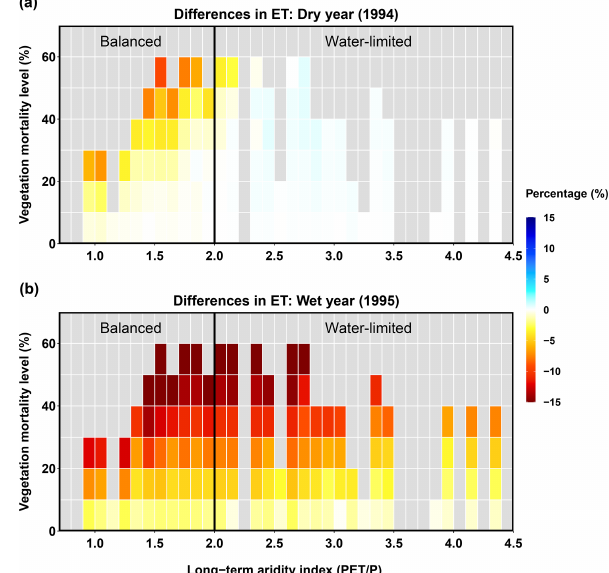
Figure 7. Relationships between long-term aridity, vegetation mor- tality level, and differences in evaporation for a dry year (1994, a ) and a wet year (1995, b ). Differences are calculated as the normal- ized differences (%) in evaporation between each evergreen mortal- ity scenario and the control run for no beetle outbreak. Vegetation mortality for each sub-basin is calculated as the percentage of ever- green patches multiplied by the level of evergreen mortality caused by beetles. Long-term aridity is defined as the temporally averaged (38 years) potential evapotranspiration relative to the precipitation.